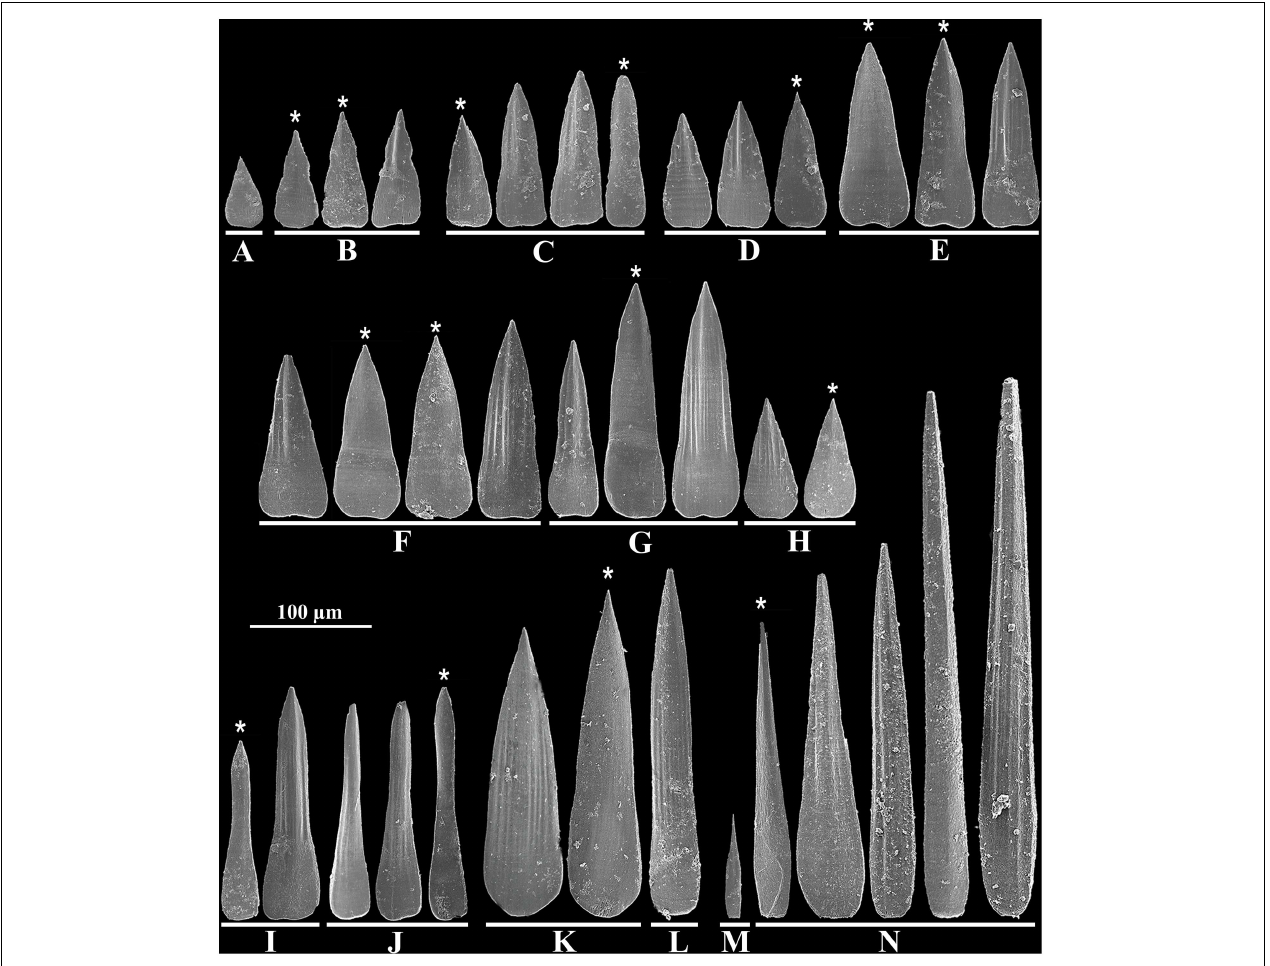
FIGURE 3 | Scutopus variabilis sp. nov. SEM photomicrographs of isolated sclerites from the different body regions: (A) , (B) , peribuccal region; (C) , foregut region; (D) , (E) , midgut region; (F–H) , midgut sac region; (I) , (J) , midventral suture line; (K) , (L) , prepallial region; (M) , (N) , pallial region. The asterisks point out the sclerites shown from the side facing the body. All in same